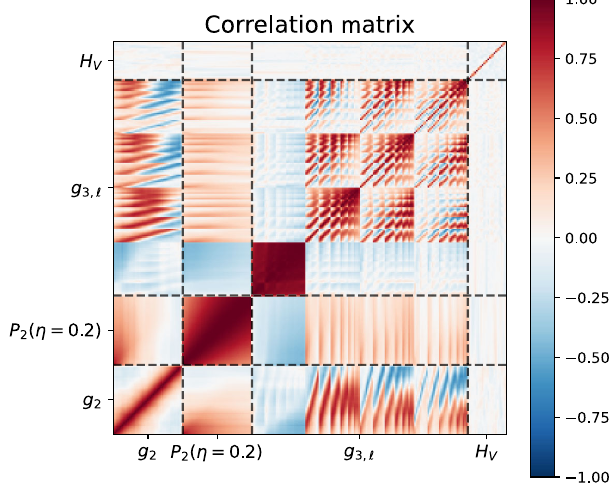
FIG. 11. Correlation matrix of the pair correlation function ( g 2 ), the pair-connectedness function ( P 2 , with reduced density η ¼ 0 . 2 ), the three-particle correlation function ( g void nearest-neighbor function ( H logical simulations run with a fiducial set of cosmological parameters. The correlation matrix is defined as the covariance matrix normalized by its leading diagonal, i.e., C with all values lying in the range ½ − 1 ; 1 (cid:2) . The labels show the statistic of interest, which are demarcated by the dotted lines. In each statistic, the bins are ordered from small scale (bottom left) to large scale (top right). For g 3 , we use four Legendre multipoles g 3 with l ∈ f 0 ; 1 ; 2 ; 3 g . Notably, the individual bins of g 3 ; l P 2 are highly correlated, and there are a number of nontrivial correlations between observables, though few with H